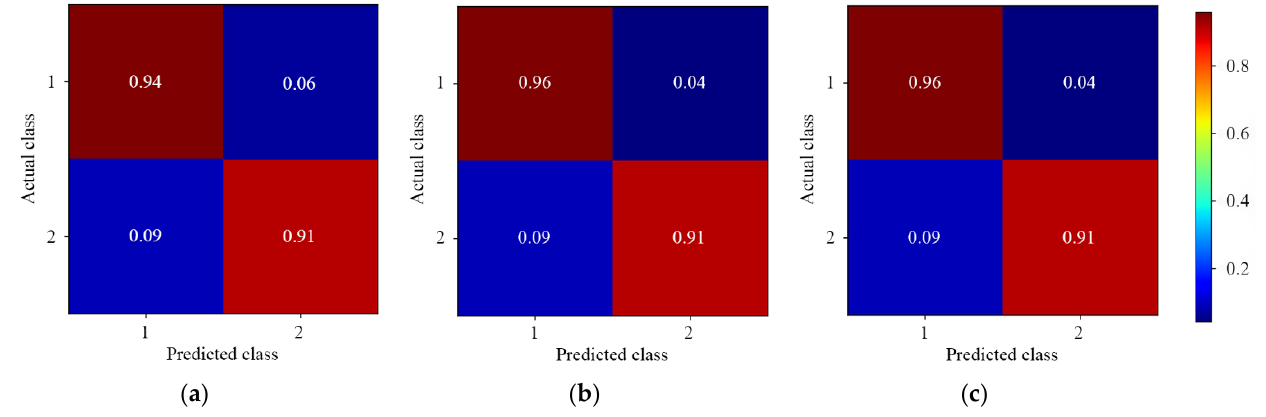
Figure 6. The normalized confusion matrix for two-level discrimination of lambda-cyhalothrin residues. ( a ) Single-depth 1D-CNN; ( b ) Symmetric multiscale 1D-CNN; ( c ) Asymmetric multiscale